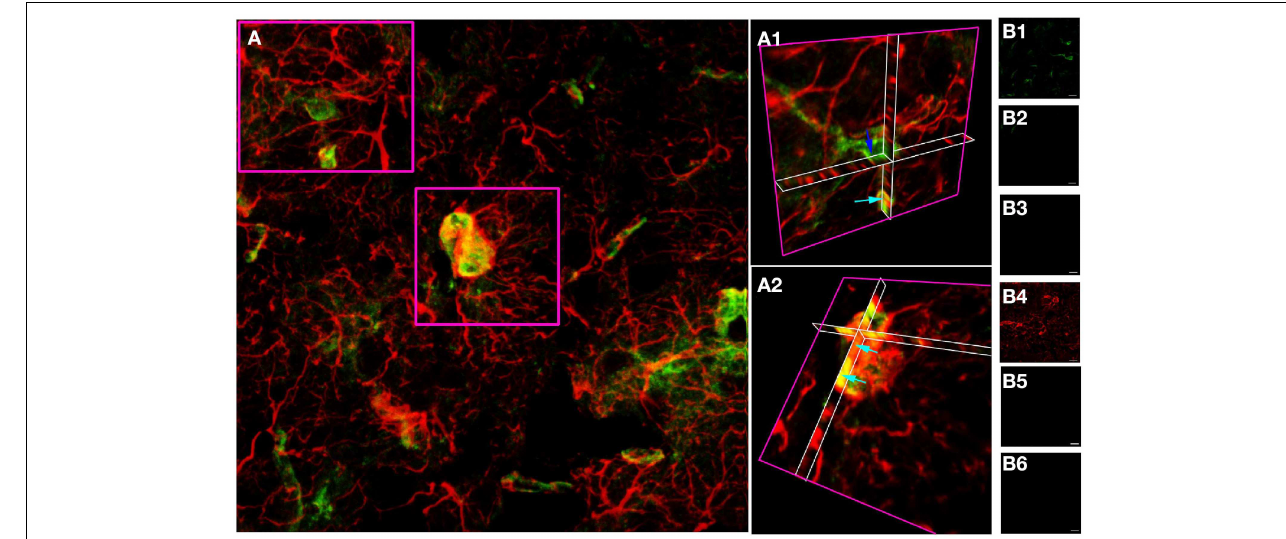
(B) Controls showing GFAP staining (B1) and absence of NG-2 staining (B2) when the NG-2 antibody was omitted from the otherwise identical protocol; NG-2 staining (B4) and no GFAP staining (B3) when the GFAP antibody was omitted, and the absence of any staining when both primary antibodies were omitted ( B5,B6 ). All images were collected and displayed using identical settings. Bar = 10 µ